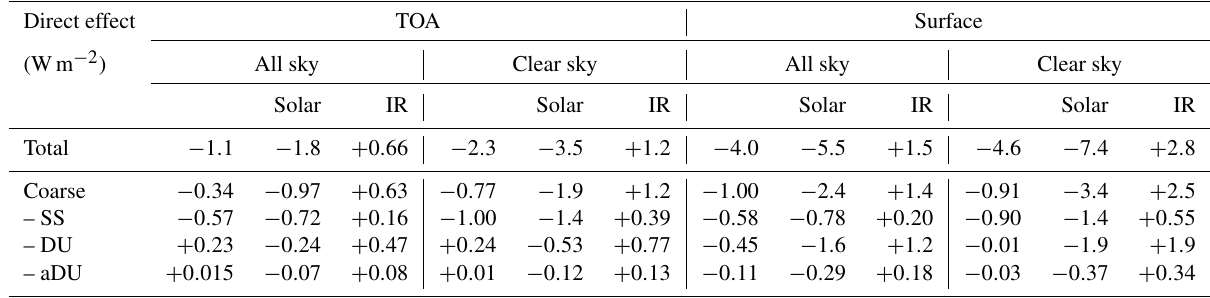
Table 3. Annual average MACv2 climatology associated aerosol radiative effects for today’s tropospheric aerosol at the top of the atmosphere (TOA) and at the surface, by separating solar and IR contributions. Aside from the total aerosol (in row 1), effects are also presented for components with an IR impact, such as sea salt (SS), dust (DU) and anthropogenic dust